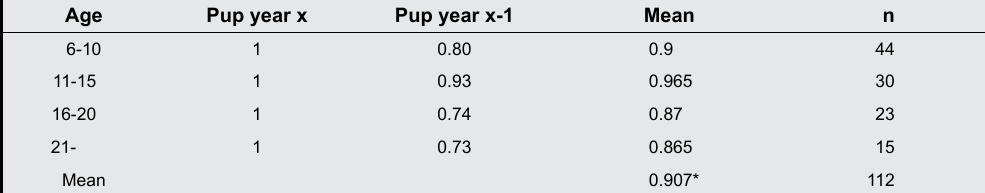
Table 3. Data on grey seal fertility rates, based on data from Norwegian breeding grey seal females (Wiig 1991). All sampled females had a pup at the time of collection (second column). Reproductive performance the year before (x-1) was estimated from scars (Corpora Albicantia) of the lutenizing ovarian follicles (Corpora Lutea). The proportion of females with CAs originating from CLs formed at time x-1 is given in the third column. Mean values of fertility rates for year x, and year x-1 are shown in fourth column.